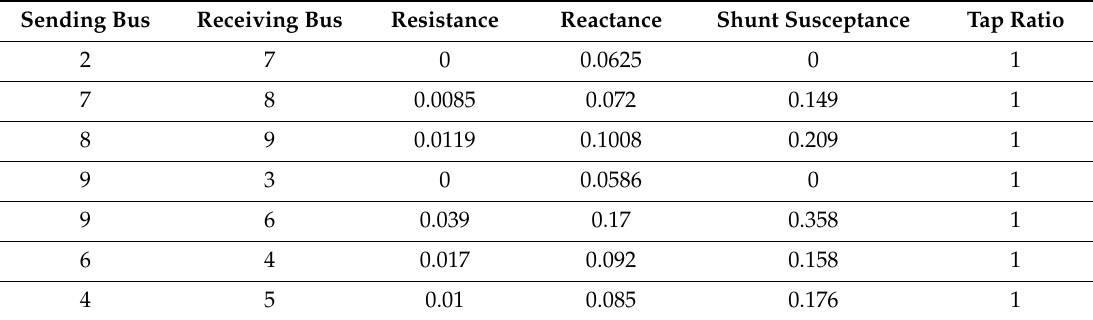
Table A1. Line bus data.